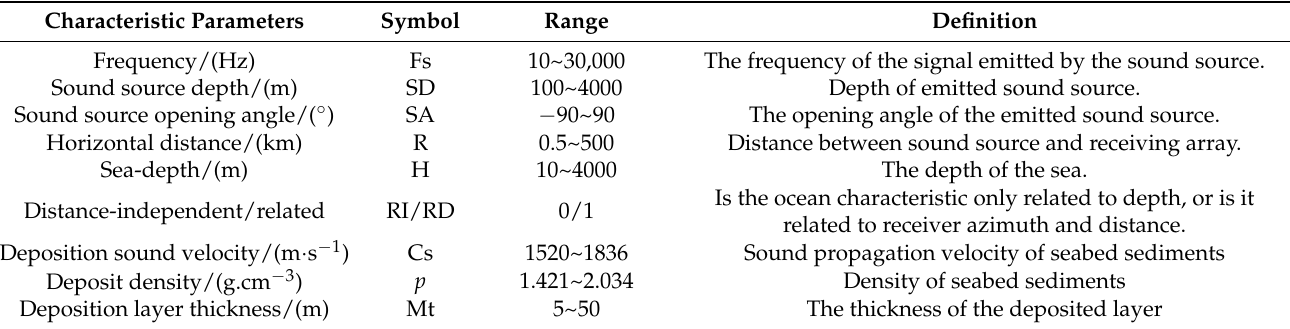
Figure 2. Deep Belief Net (DBN) mode structure. Table 1. Characteristic parameters.